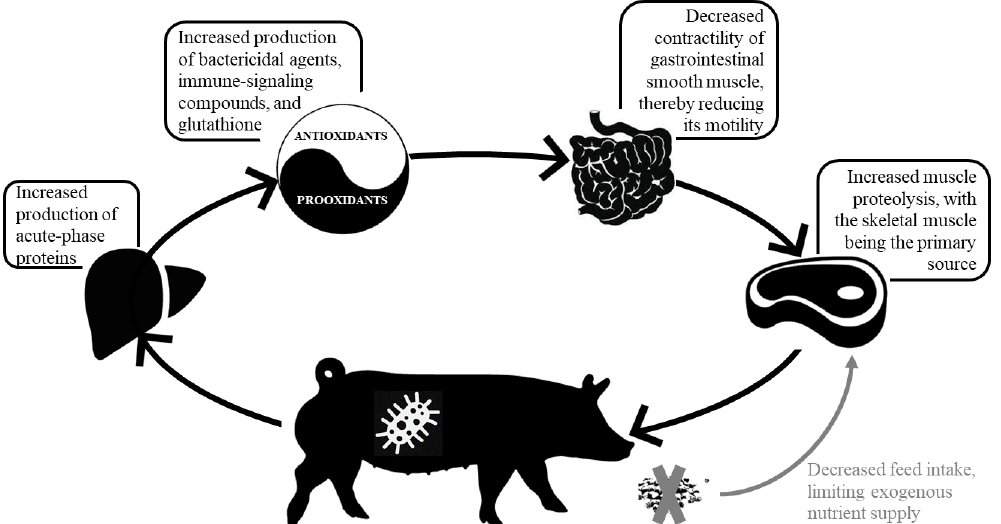
Figure 1. Pigs subjected to stimulation of immune system experience increased production of acute- phase proteins (e.g., C-reactive protein, serum amyloid A, haptoglobin, and pig-MAP). Additionally, there is a marked syntheses of endogenous antioxidants to mitigate oxidative stress, including the production of immune-signaling compounds, the release of superoxide dismutase by phagocytic cells and the increased turnover of glutathione, which is a key, non-enzyme antioxidant in the body. Furthermore, a higher concentration of circulating pro-inflammatory cytokines decreases the con- tractility of gastrointestinal smooth muscle, thereby reducing its motility and sparing energy and nutrient expenditure for digestion. In attempt to minimize metabolic costs, pigs mobilize nutrients, particularly amino acids, from body reserves. This is mediated by proinflammatory cytokines and reactive oxygen species, which stimulate the I κ B/NF- κ B signaling pathway, eventually activating the ubiquitin proteasome system, and further triggering muscle proteolysis, with the skeletal muscle being the primary source. The reduced feed intake, which is mainly a result of upregulation of feed intake-lowering (anorexigenic) peptides and downregulation of orexigenic peptides, limits the ex- ogenous nutrient supply and aggravates muscle proteolysis.